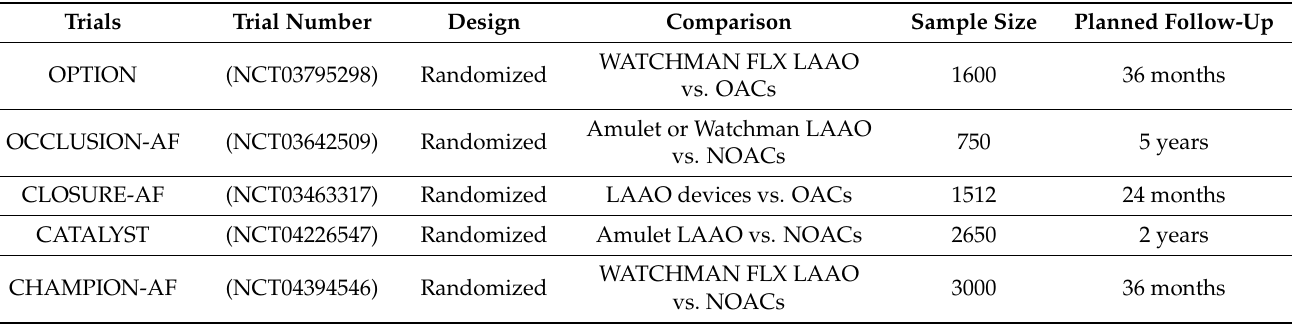
Table 4. Ongoing registered clinical trials (refer to: